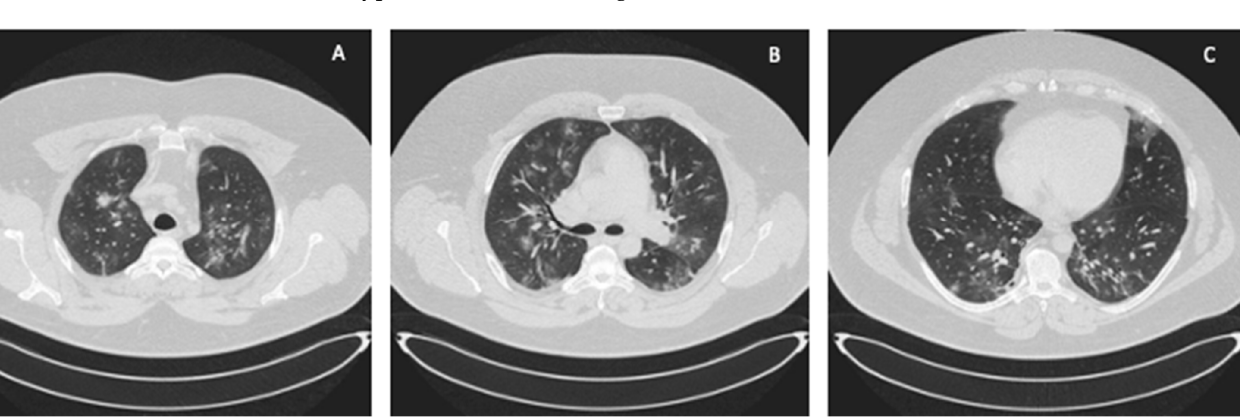
Figure 3. ICU: ( A )upper lung segments; ( B ) middle lung segments; ( C ) basal lung segments (Case